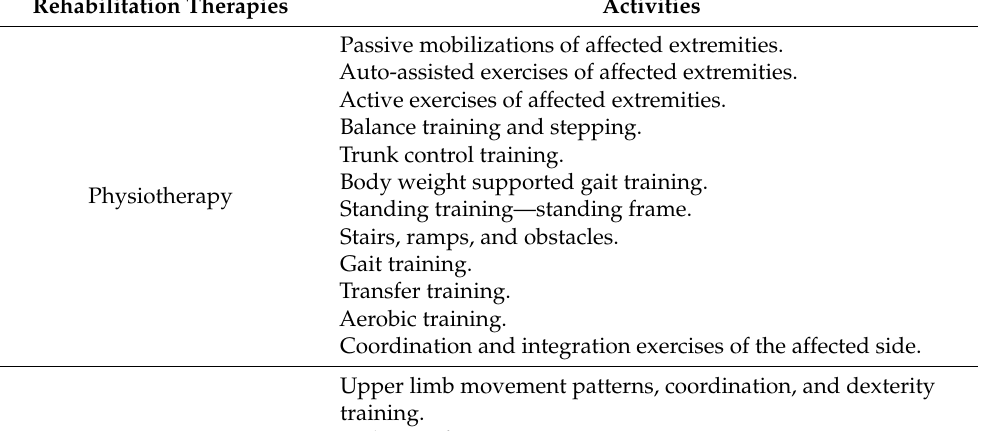
Table 1. Description of therapies and included therapies during the rehabilitation program. Rehabilitation